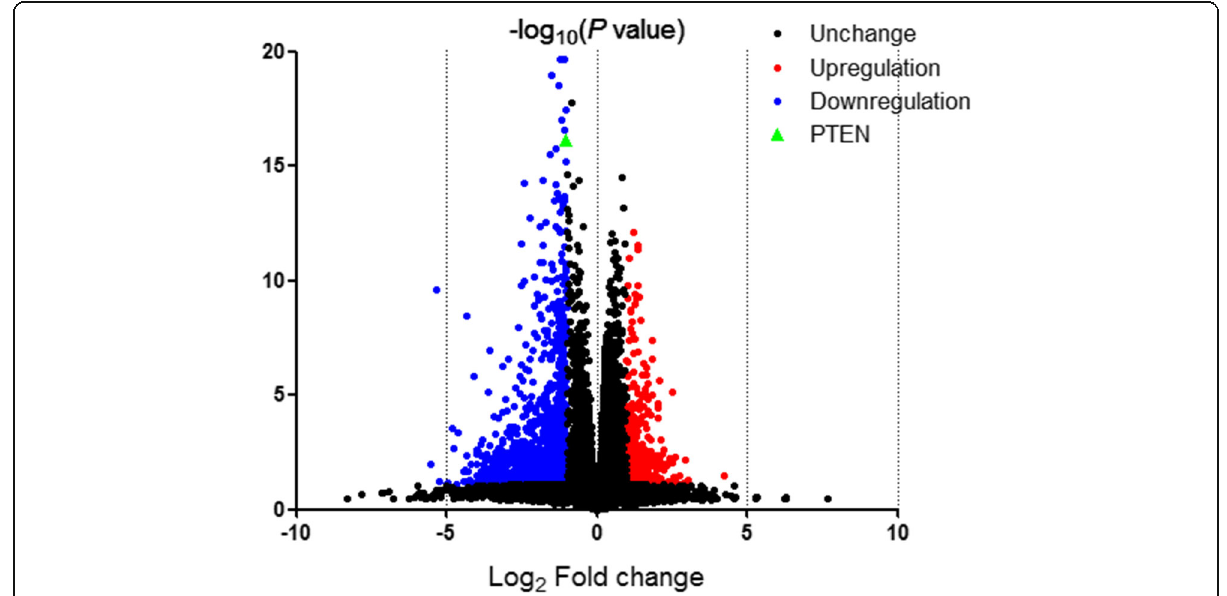
Fig. 4 Volcano plot for DEGs. Notes: Red: up-regulated genes; blue: down-regulated genes; black: non-differentially expressed genes; green: